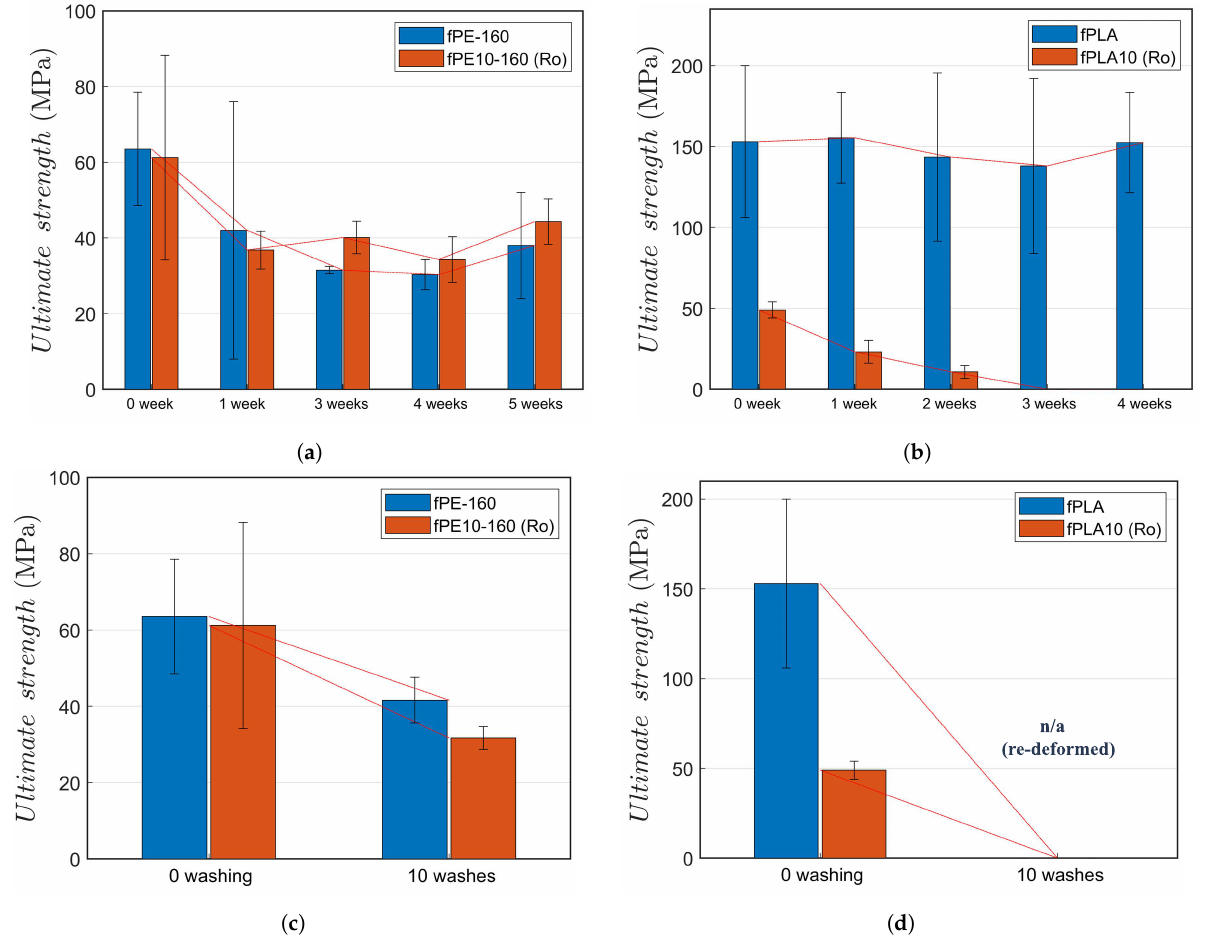
Figure 3. The effect of UV exposure on the ultimate strength of: ( a ) PE fibres with and without rosin; ( b ) PLA fibres with and without rosin. The effect of standard washing (70 ℃ ) on the ultimate strength of: ( c ) PE fibres with and without rosin; ( d ) PLA fibres with and without